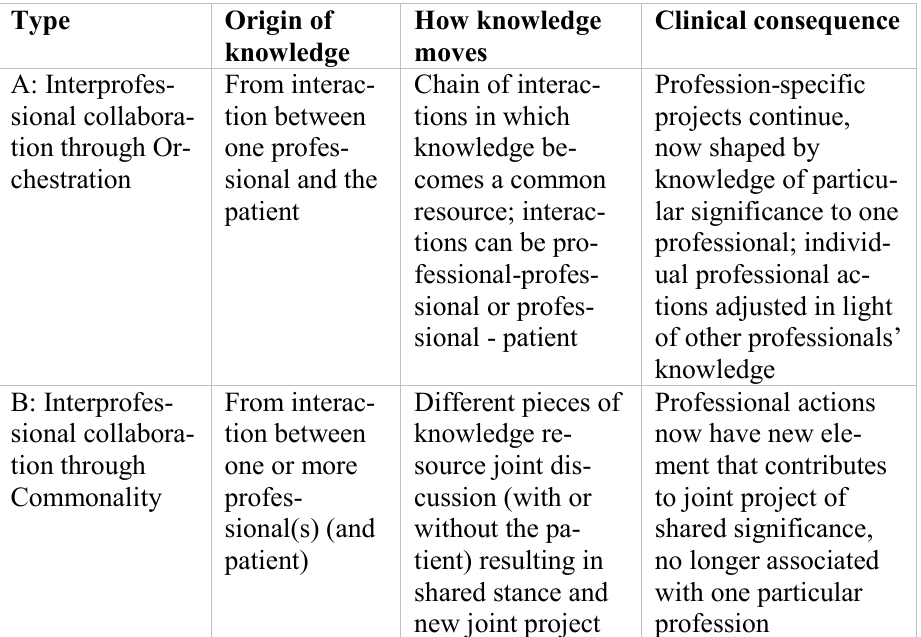
Conceptual summary of the two different types of knowledge sharing through inter- professional collaboration using Schatzki´s concept of Orchestration and Common-